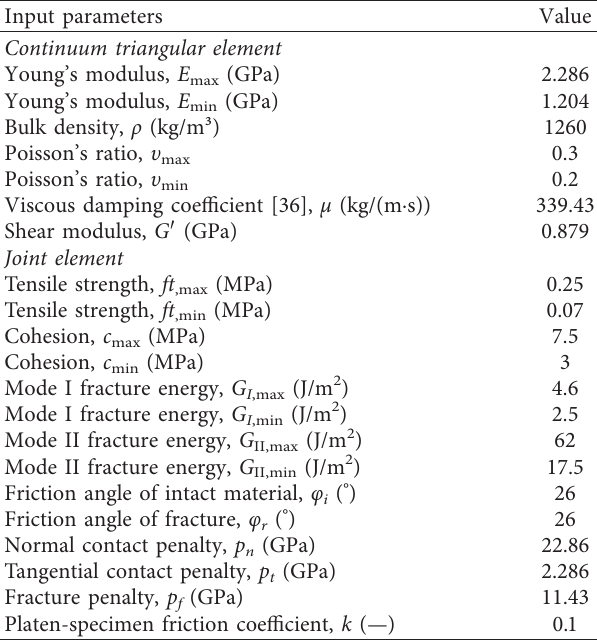
Table 1: FDEM input